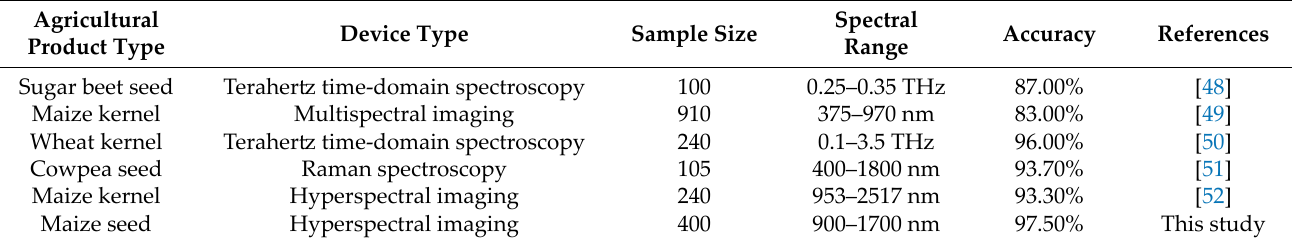
Table 4. Comparison of the proposed method with related